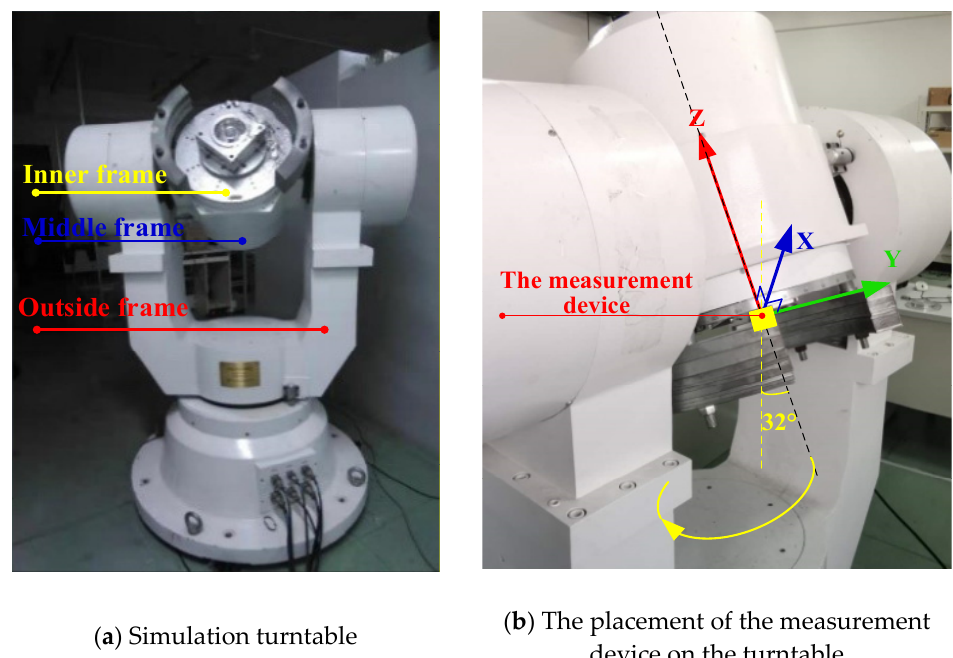
Figure 8. Simulation turntable and the placement of the measurement device.